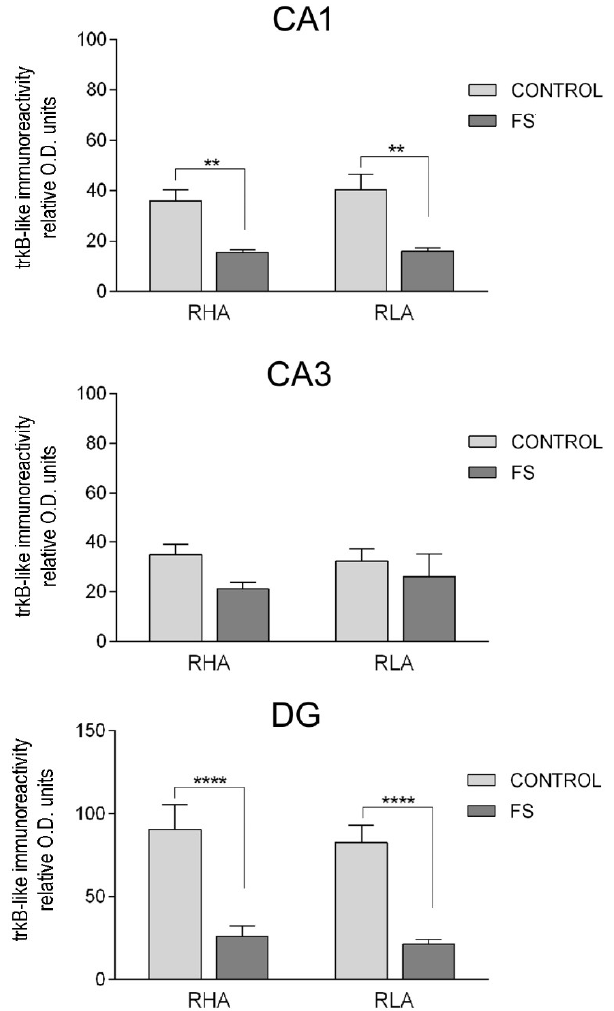
Figure 7. Densitometric analysis of the trkB-like immunoreactivity in the CA1 and CA3 sectors of the Ammon’s horn and in the dentate gyrus (DG) of the ventral hippocampus, in the baseline conditions (CONTROL) and after forced swimming (FS). Columns and bars denote the mean ± S.E.M. of six rats, in each experimental group. Two different sections were analyzed for each rat. **: p < 0.01; ****: p < 0.0001 (Tukey’s post hoc test or Sidak’s correction for multiple comparisons).